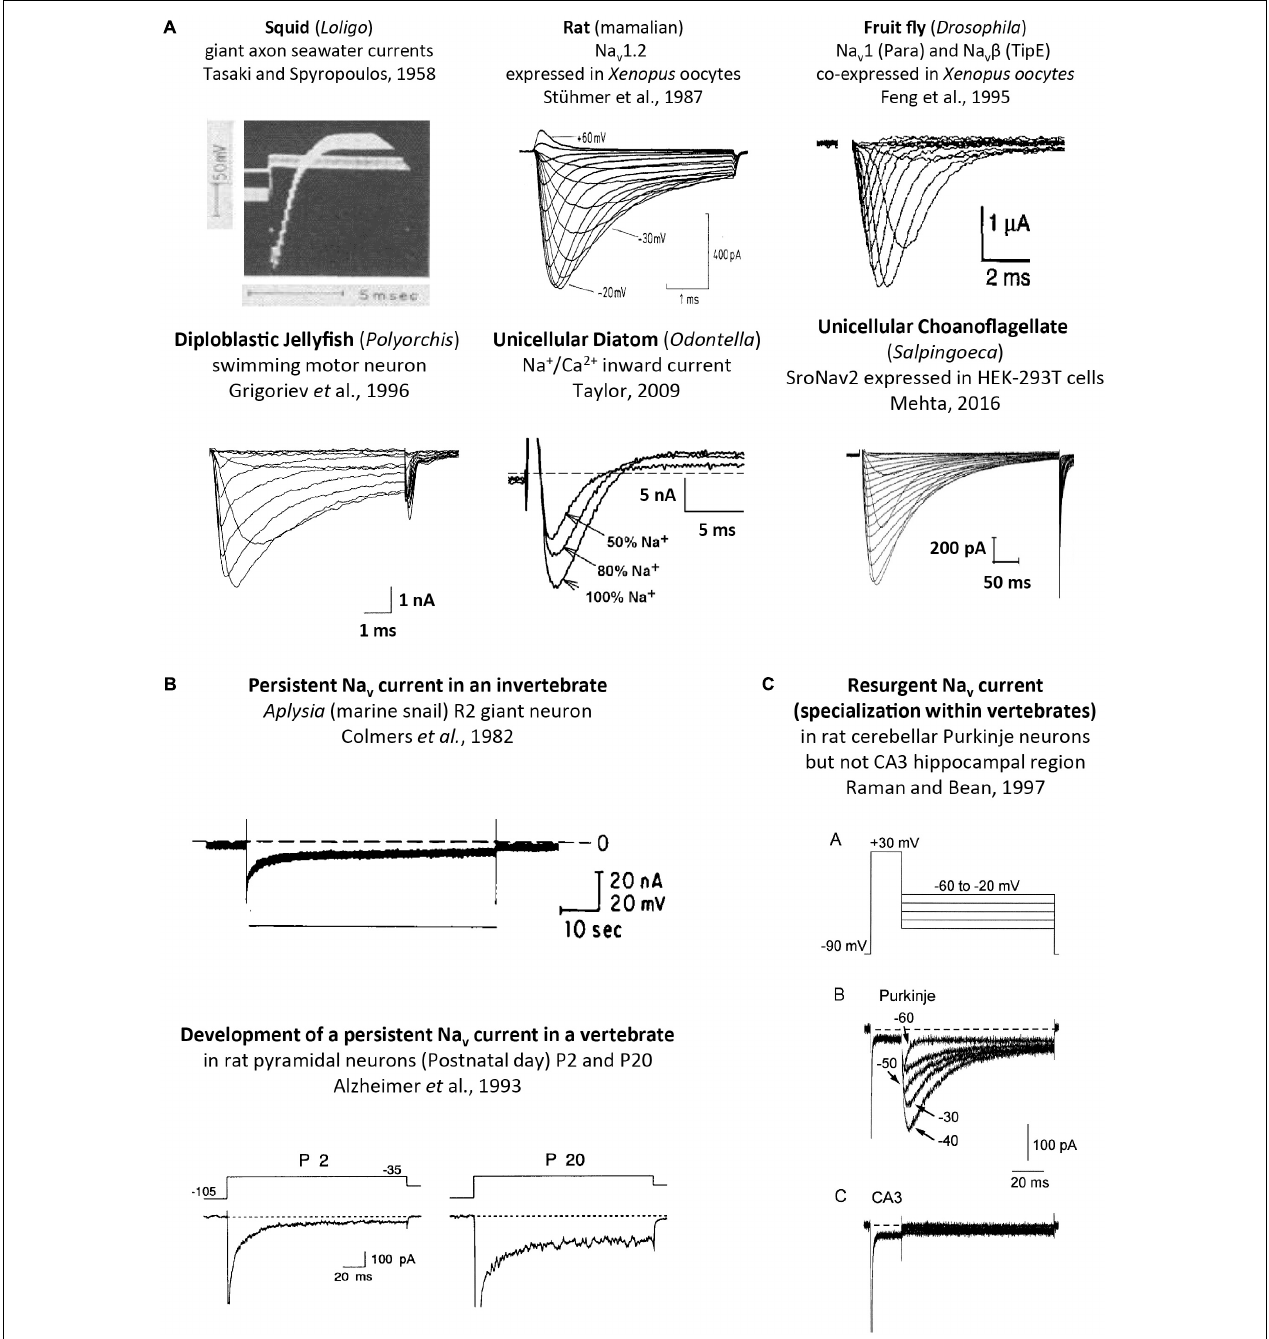
FIGURE 9 | Sodium ion containing currents recorded in voltage-clamp studies of cells or expressed genes derived from single cell eukaryotes, invertebrates and vertebrates. (A) Squid, rat, fruit fly, jellyfish, diatom and choanoflagellates, reproduced with permission from Tasaki and Spyropoulos (1958), Stühmer et al. (1987), Feng et al. (1995), Grigoriev et al. (1996), Taylor (2009), Mehta (2016). (B) Persistent sodium currents in both invertebrates (top panel) and vertebrate neurons (bottom panel), reproduced with permission from Colmers et al. (1982) and Alzheimer et al. (1993), respectively. (C) Resurgent sodium currents, a property associated only with particular vertebrate neurons, reproduced with permission from Raman and Bean (1997).